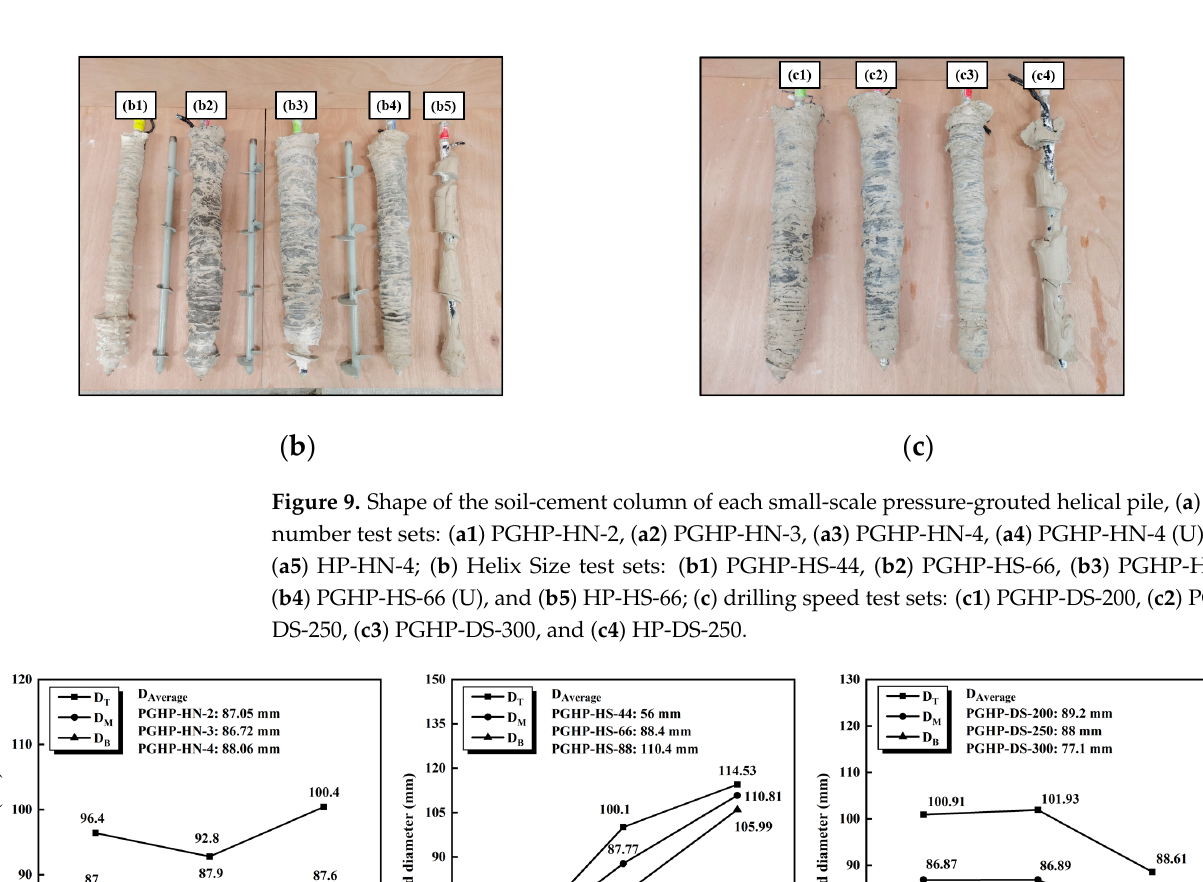
Figure 10. The small-scale pressure-grouted helical pile dimensions of the compression test, ( a ) he- lix number test sets, ( b ) helix size test sets, and ( c ) drilling speed test sets.